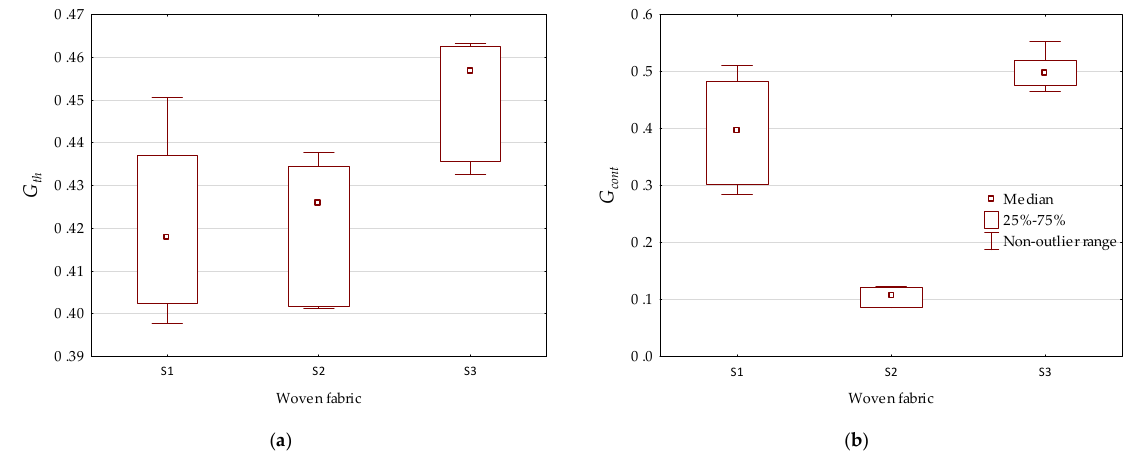
Figure 5. Influence of material on phase connectedness: ( a ) strips’ phase; ( b ) strip contacts’ phase.